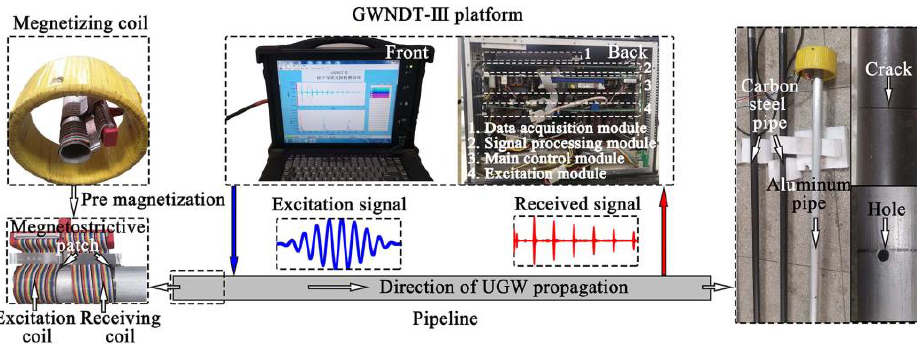
Figure 13. Schematic diagram of magnetostrictive UGW testing.